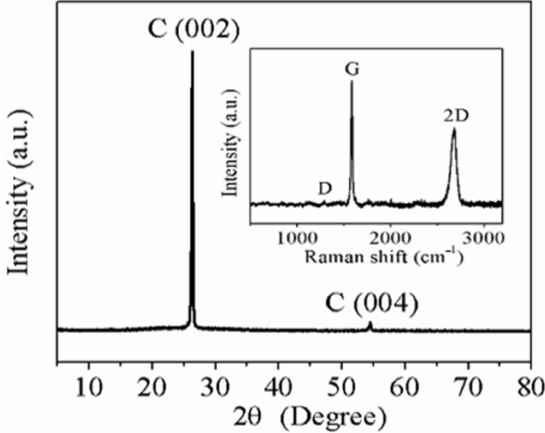
Figure 3. XRD pattern of HCGAF (inset: Raman spectroscopy of HCGAF).